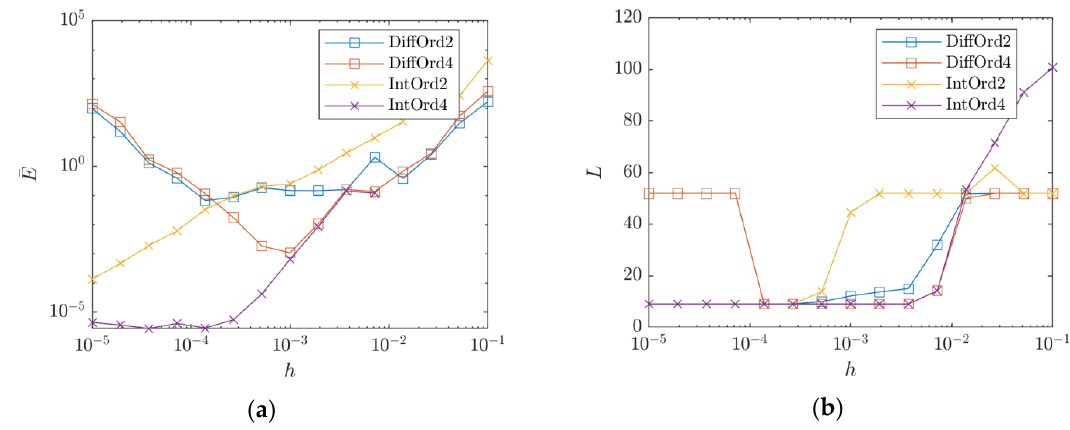
Figure 6. Results of the reconstruction of system Equation (37) using integration and differentiation of orders 2 and 4 with respect to the stepsize. ( a ) mean error E = (cid:107) v k − H k ( X ) (cid:107) by all 3 dimensions; ( b ) overall number of terms L in the reconstruction, where L = 9 corresponds to the original system (37). Square markers correspond to the di ff erentiation-based approach; crosses correspond to the integration-based approach. We tested 15 stepsizes, 10 experiments were carried out with each stepsize.